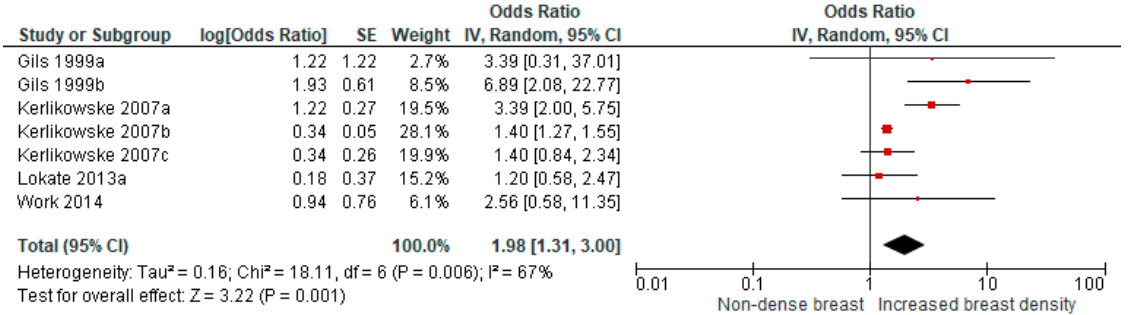
Figure 3. Pooled analysis for breast cancer risk in relation to increased breast density over time (studies presenting odds